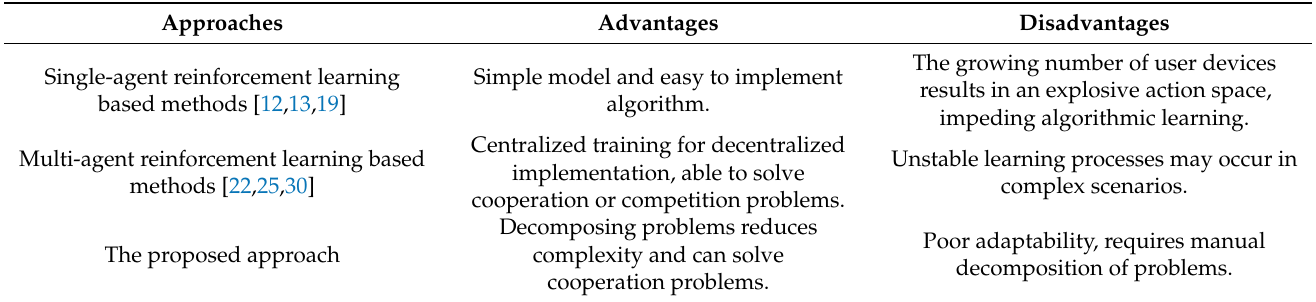
Table 1. Comparison of